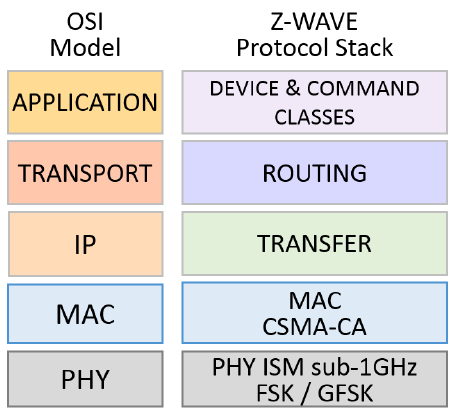
Figure 13. Z-Wave protocol